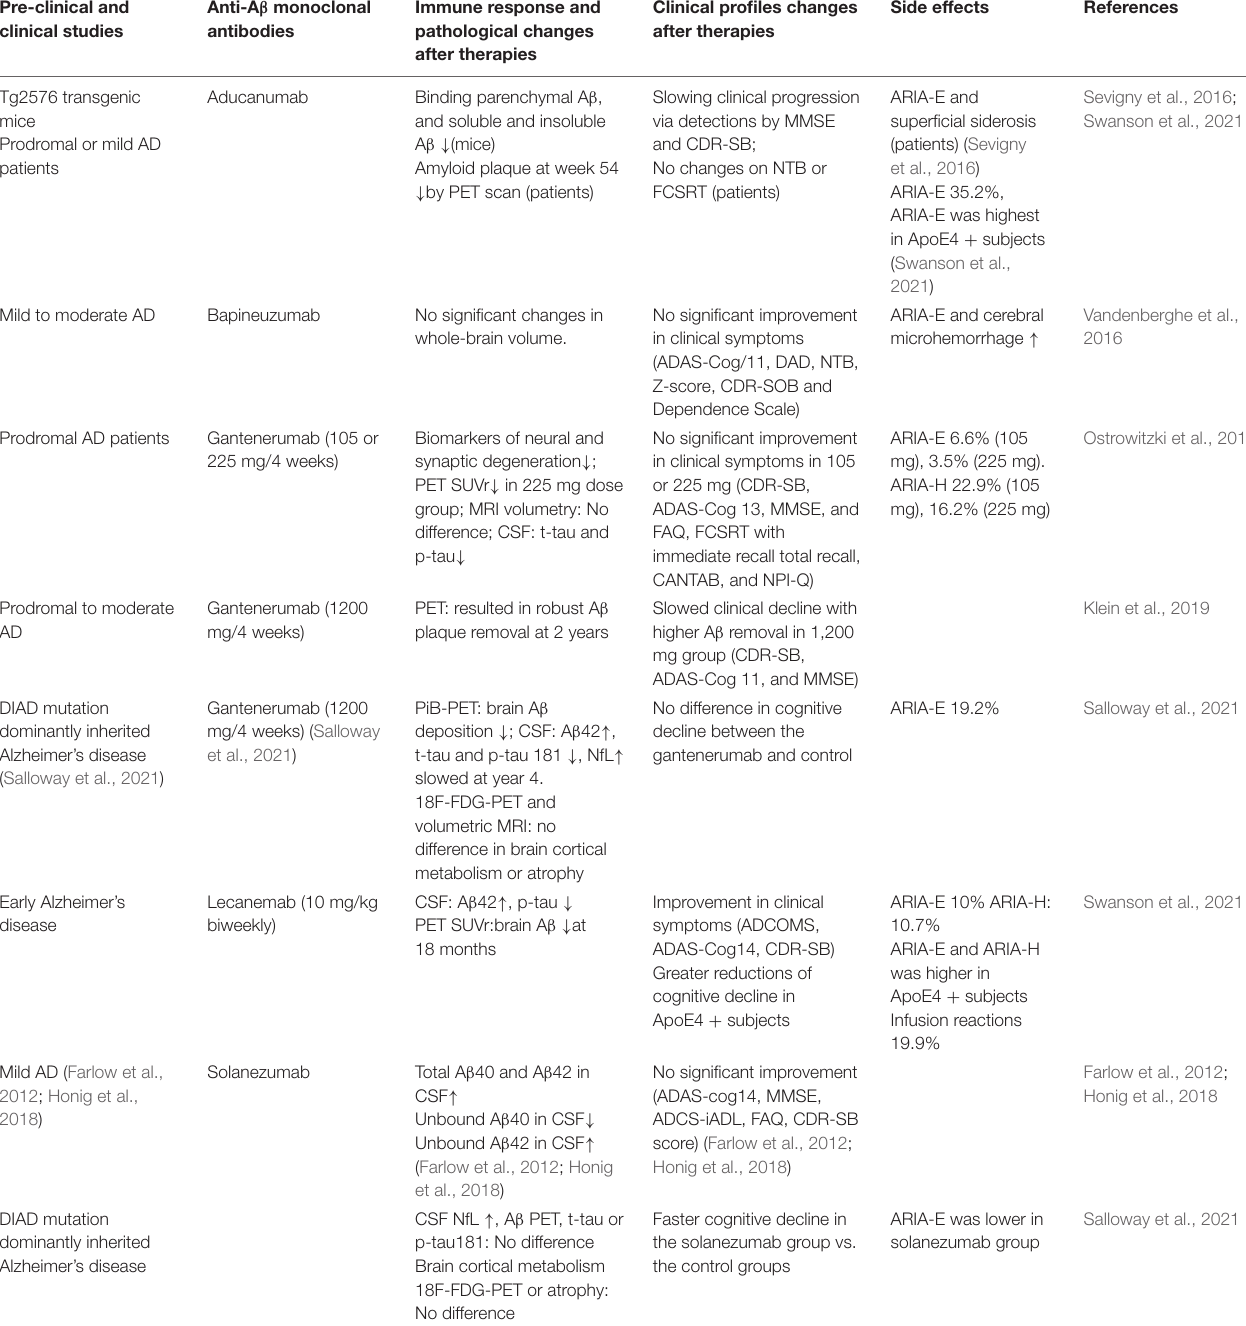
TABLE 1 | Treatments of patients with AD and animal models with anti-A β monoclonal